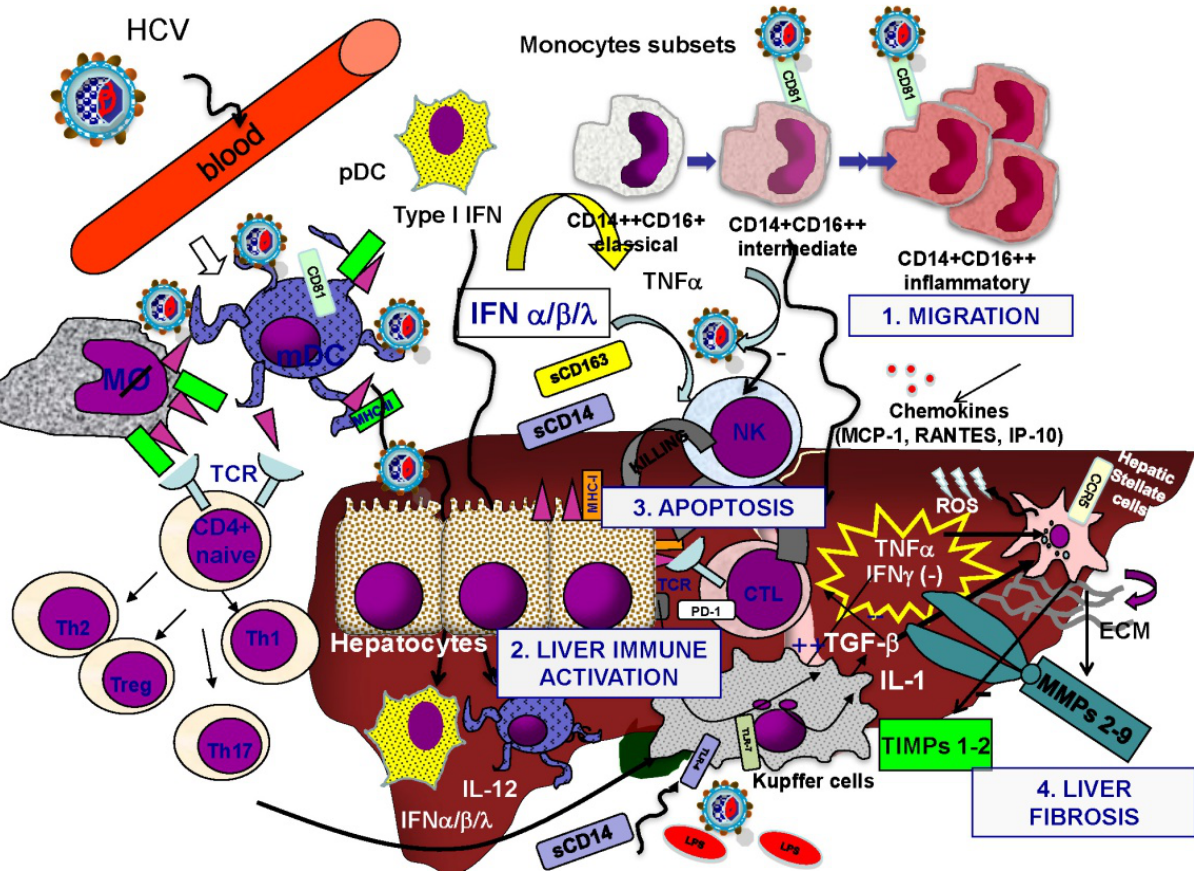
leading to the recruitment of inflammatory cells such as cytotoxic T lymphocytes (CTL), neutrophils, monocytes, DCs, and NK cells to the liver, causing liver cell injury and chronic hepatitis [33–35]. Figure 1. Immunopathogenesis of hepatitis C virus (HCV)-induced liver damage. HCV directly interacts with monocytes/macrophage/dendritic cell compartment via CD81 or toll-like receptor (TLR)-7 inducing a pro-inflammatory state and allowing the presentation to naive T and B cells. The increased circulation of chemokines leads to the migration of all these cells into the liver. Natural killer (NK) cells play a central role in control viral replication, but HCV is able to inhibit NK functions. HCV in the liver causes infection of hepatocytes that are a target for the activated effector cells, such as cytotoxic T lymphocytes (CTL), NK, myeloid dendritic cells (mDC) inducing apoptosis. A complex state of chronic immune activation is maintained in the liver and includes also Kupffer cells. In this milieu of pro-inflammatory cytokines (interleukin (IL)-1, tumor necrosis factor (TNF)- α , transforming growth factor (TGF)- β 1, IL-12) and oxidative stress (ROS), hepatic stellate cells (HSC) are activated to produce extracellular matrix and to induce a dysregulation of the imbalance between matrix metalloproteinases (MMPs) and tissue inhibitors of matrix metalloproteinases (TIMPs), thus leading to liver fibrosis. Th, T helper; IFN, interferon; sCD, soluble CD; RANTES, regulated on activation normal T cell expressed and secreted; CCR5, C – C chemokine receptor type 5; ECM, extracellular matrix; LPS, lipopolysaccharide; pDC, plasmacytoid dendritic cells; IP, Interferon-gamma-induced protein; TCR, T-cell